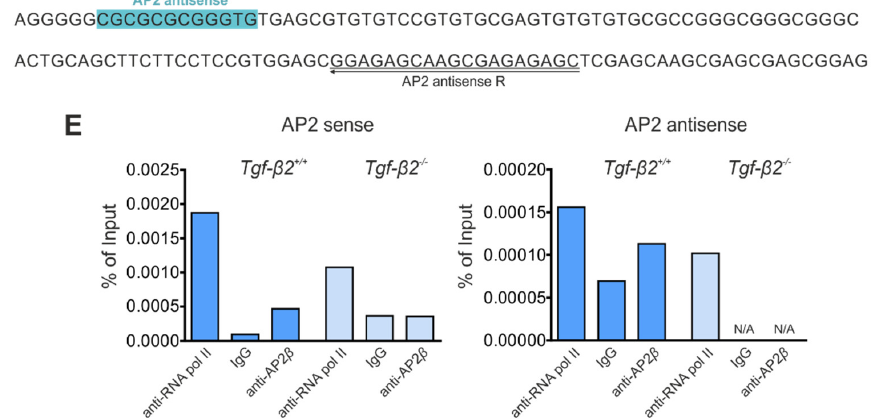
Figure 4. Transcriptional regulation of Kcc2 by TGF- β 2 in mouse forebrain. Quantitative RT-PCR analysis for the transcription factors Ap2 α , Ap2 β , ( A ) Sp1 , Nrsf, ( B ) Egr4 , c-Fos and c-Jun ( C ) on cDNA from mouse forebrain at embryonic day ( E ) 17.5 from Tgf-β2 +/+ and Tgf-β2 −/− mice ( # p < 0.05 for significant downregulation compared to wildtype using two-tailed unpaired Student’s t -test, n = 6–7). Data are shown as mean ± SEM relative to mean of wildtype littermates. ( D ) AP2 sense (purple) and antisense (turquoise) binding sites to the Kcc2 promoter. Underlined sequences represent forward (F) and reverse (R) primer sequences used to detect AP2 binding. ( E ) Quantitative PCR for putative AP2 sense and antisense sequences on Kcc2 promoter, following chromatin immunoprecipitation assay with AP2β antibody in Tgf-β2 +/+ and Tgf-β2 −/− mouse forebrain. RNA polymerase II and mouse IgG represent positive and negative control, respectively. The quantification is representative of n = 4 per genotype.